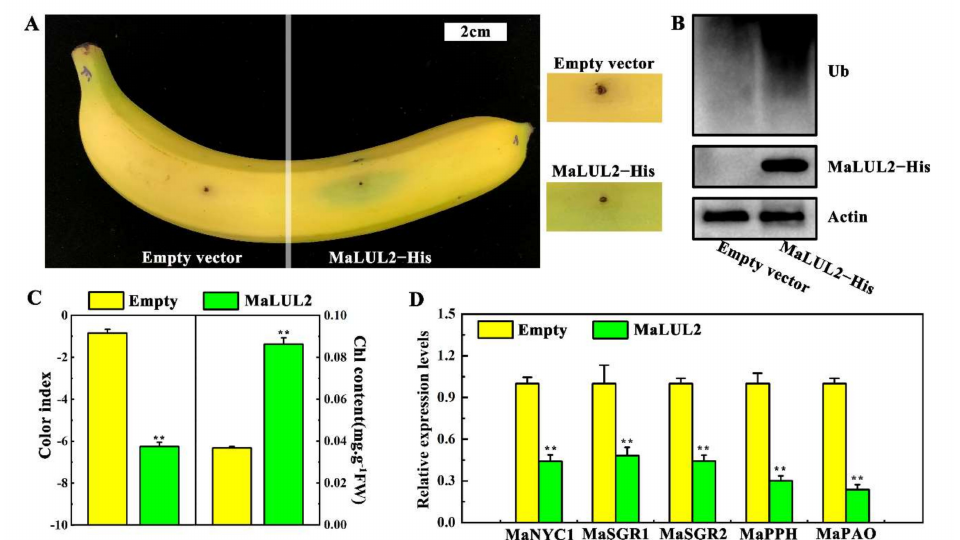
Figure 6. Effect of transient overexpression of MaLUL2 in banana fruit peel on chlorophyll degradation. ( A ) Appearance of banana fruit transiently overexpressing MaLUL2 and empty vector (control). ( B ) Immunoblotting analysis showing the level of ubiquitination and MaLUL2 protein in MaLUL2 − overexpressing and control banana fruit peel. ( C ) Changes of the color index and total